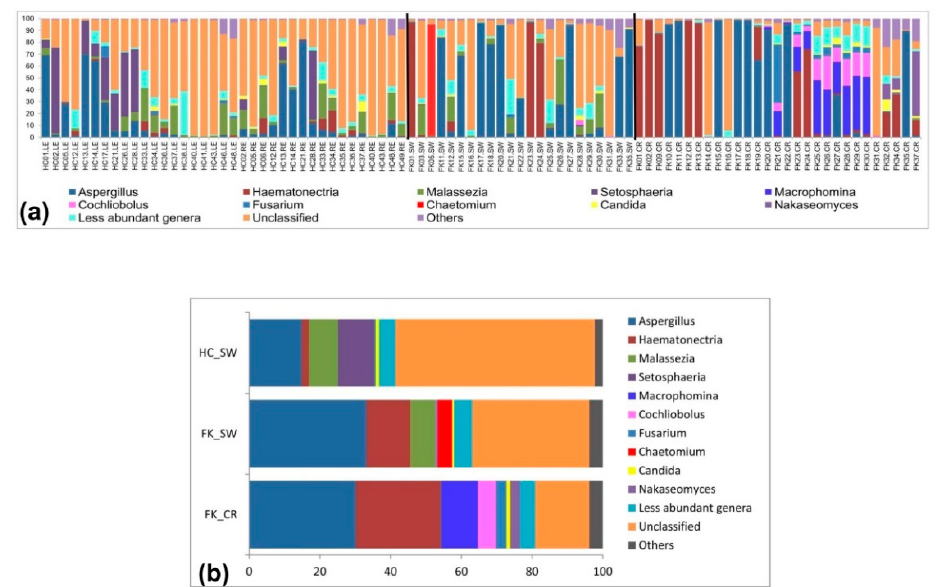
Figure 3. Abundance (%) ( a ) and average abundance (%) of fungal genera ( b ) from microbiomes of conjunctival swabs of healthy controls (HC-SW, n = 37), conjunctival swabs of fungal keratitis patients (FK-SW, n = 23), and corneal scrapings of fungal keratitis patients (FK-CR, n = 29).